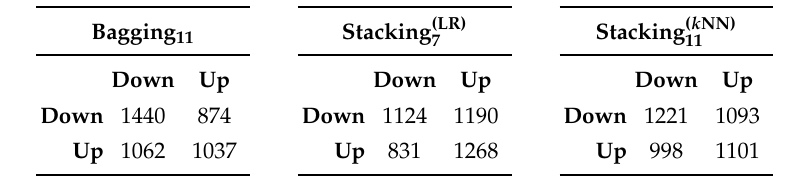
Table 12. Confusion matrices of Averaging 11 , Bagging 11 , Stacking (LR) CNN-BiLSTM as base model for XRP